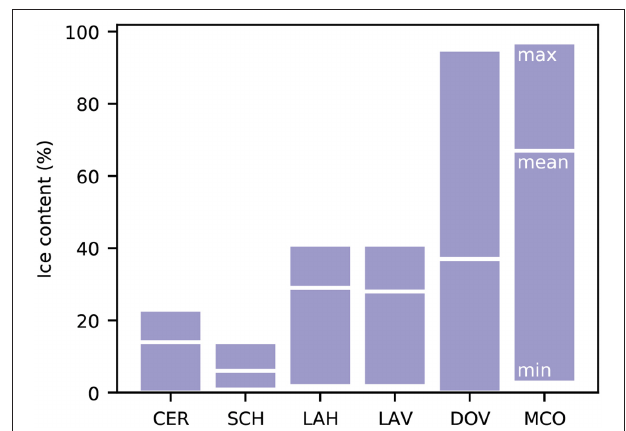
FIGURE 13 | Minimum, mean, and maximum estimated ice content for the entire tomogram of all six sites considering the electrical resistivity models indicated in Figure 12